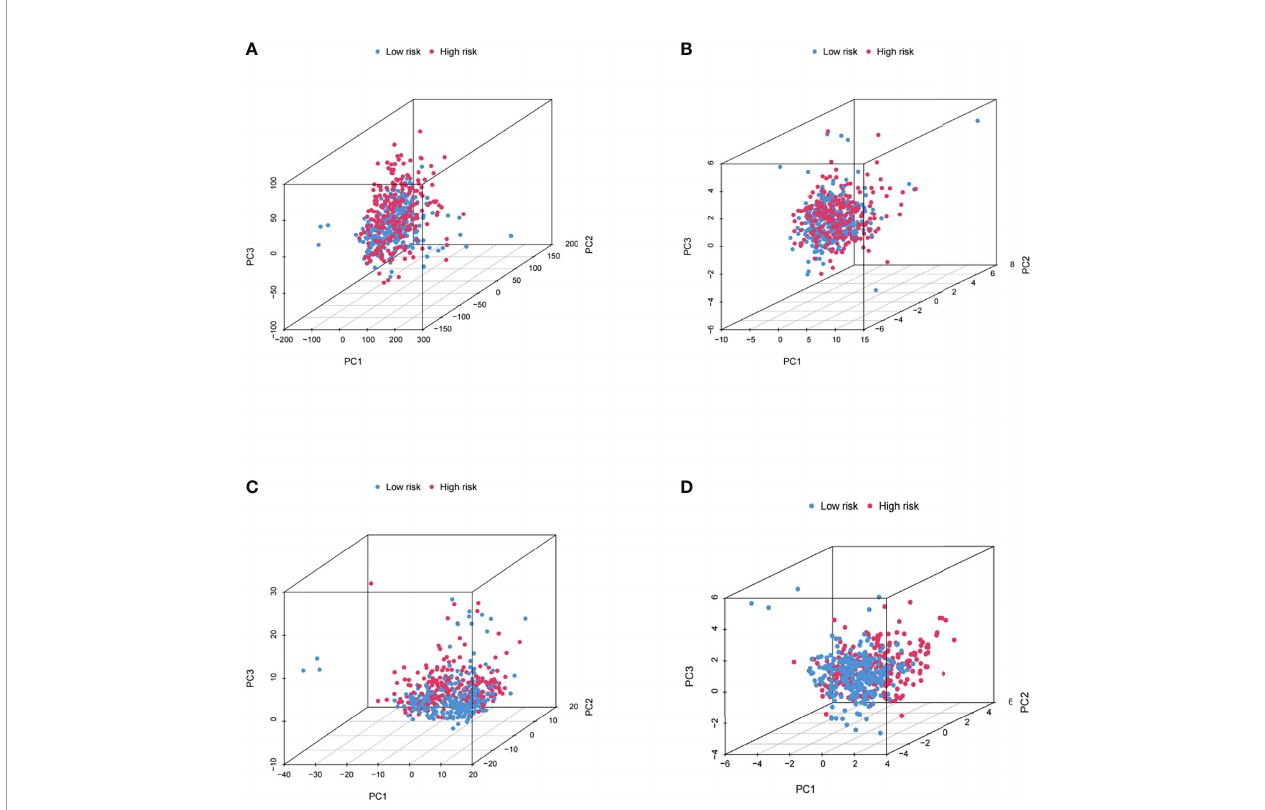
FIGURE 7 | Principal component analysis between both groups based on (A) the entire gene expression pro fi les, (B) 23 m6A genes, (C) the m6A-related lncRNAs, and (D) the risk model based on the representation pro fi les of the 10 m6A-related lncRNAs in the entire TCGA